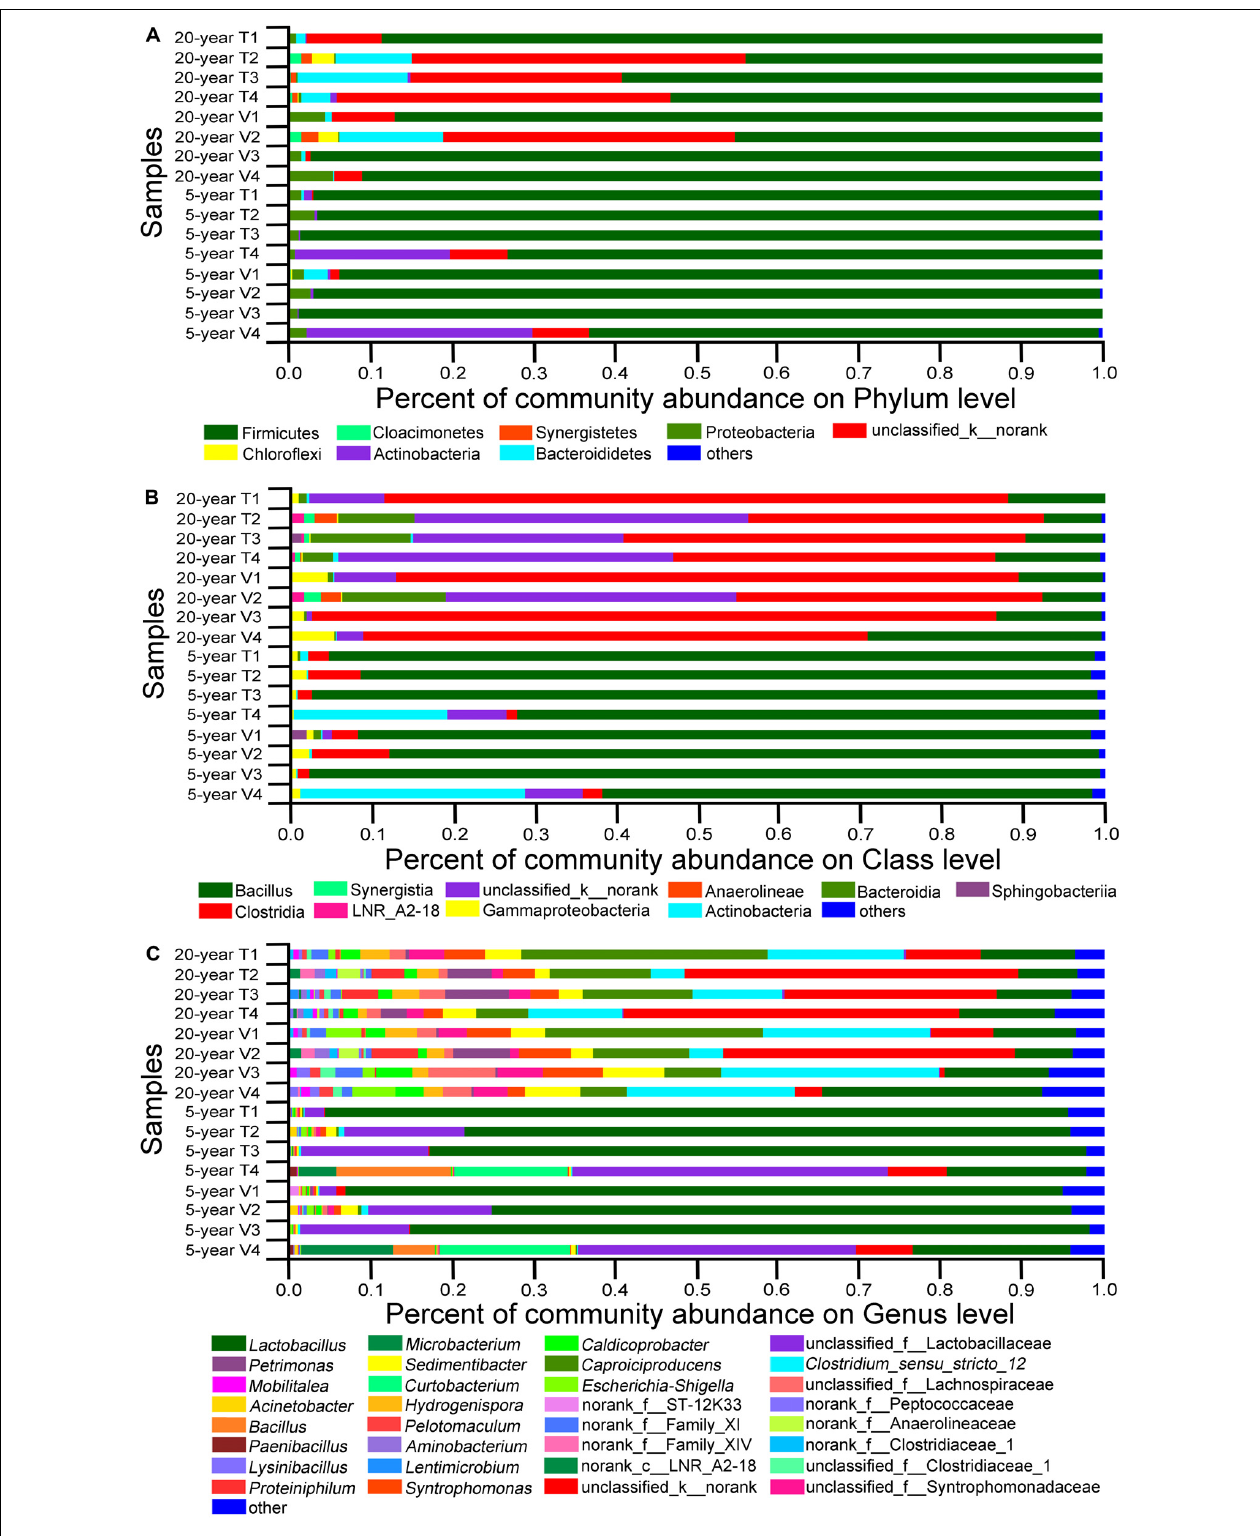
FIGURE 5 | The relative abundances of viable bacteria at different levels of phylum (A) , class (B) , and genus (C) . Each PM type had four replicates. The 5-year PM and 20-year PM were treated with PMA for identifying viable bacteria. The prefixes of “k__,” “p__,” “c__,” “o__,” and “f__” indicate that OTUs were annotated only to the level of kingdom, phylum, class, order, or